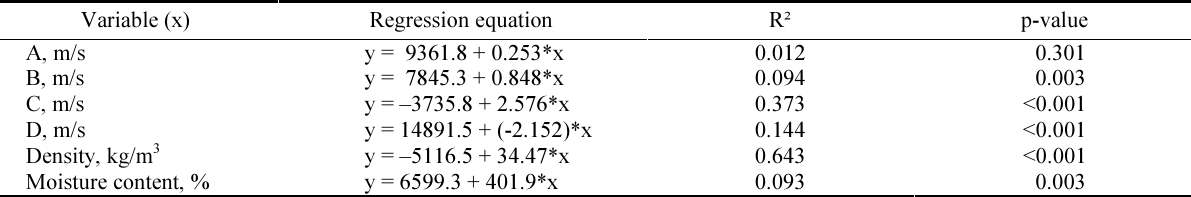
Table 3. Predicting modulus of elasticity (y) with different variables (x) individually Variable (x) Regression equation R² p-value A, m/s y = 9361.8 +